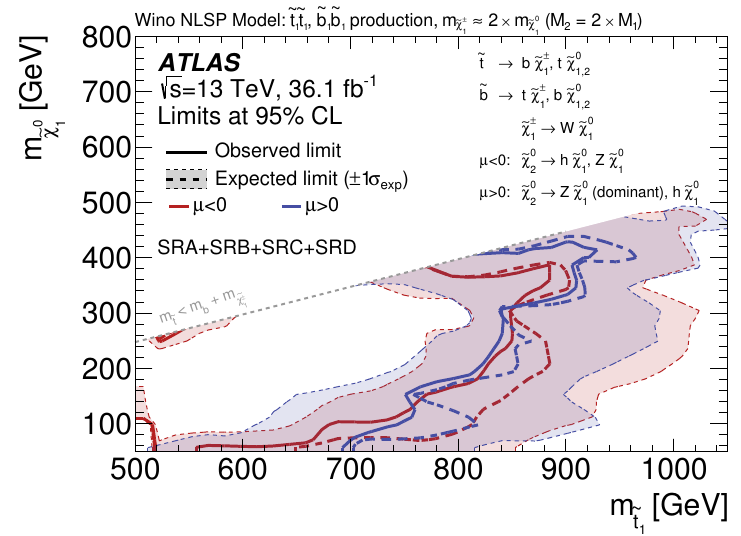
Figure 11. Observed (solid line) and expected (dashed line) exclusion contours at 95% CL as a function of ~ t 1 and ~ (cid:31) 0 1 masses for the Wino NLSP pMSSM model for both positive (blue) and negative (red) values of (cid:22) . Uncertainty bands correspond to the (cid:6) 1 (cid:27) variation of the expected limit.